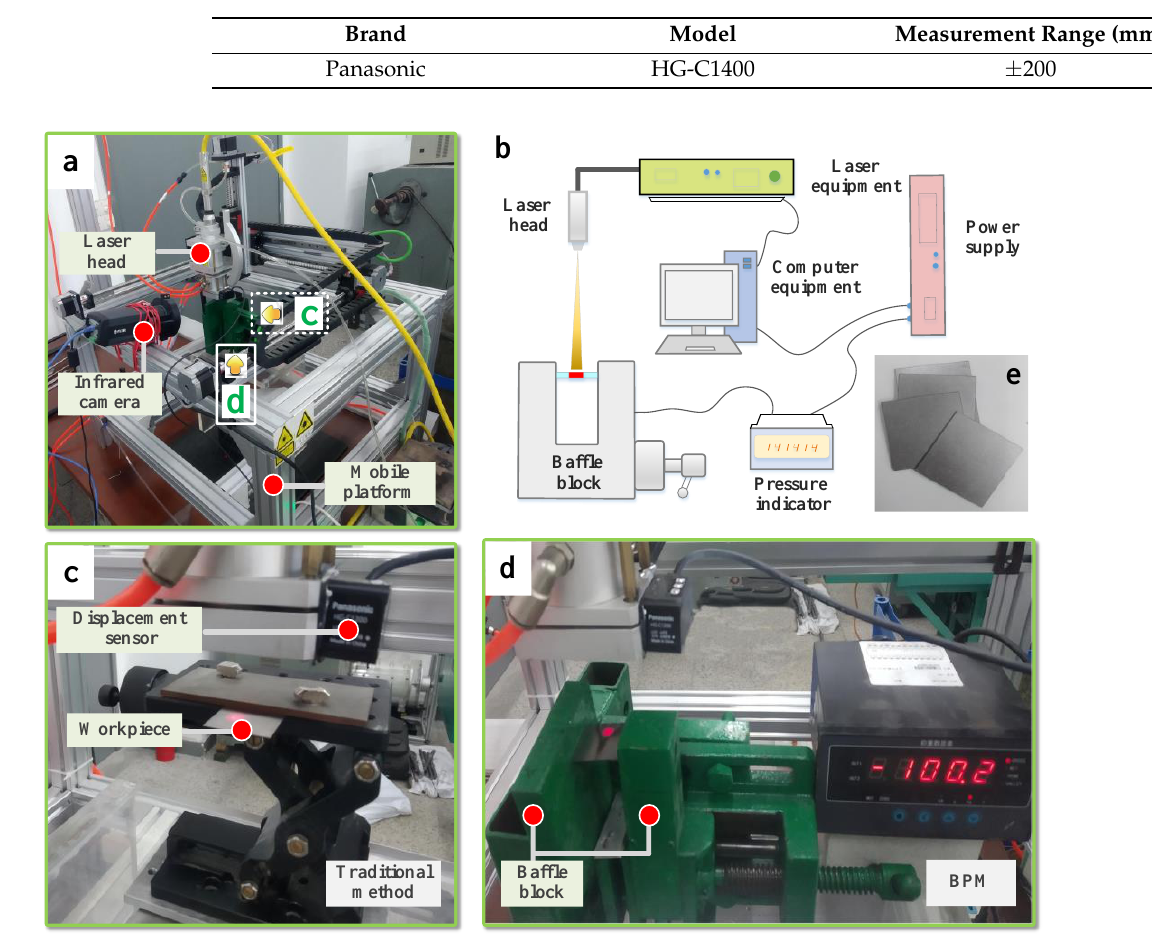
Table 4. Parameters of the displacement measuring instrument.